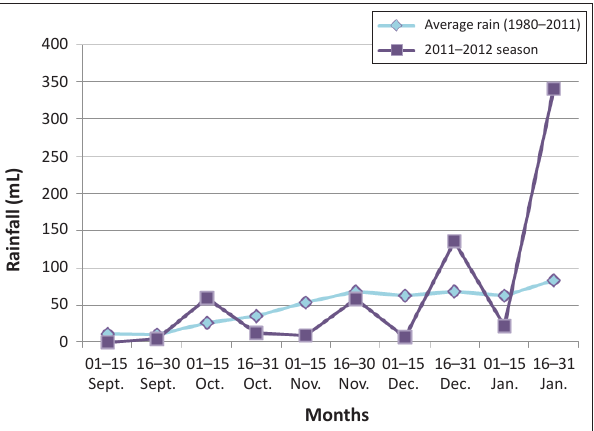
FIGURE 1: Comparison of the average bi-weekly rainfall patterns recorded at the Malelane Research Unit over the period 1980–2011 with that recorded during a period in